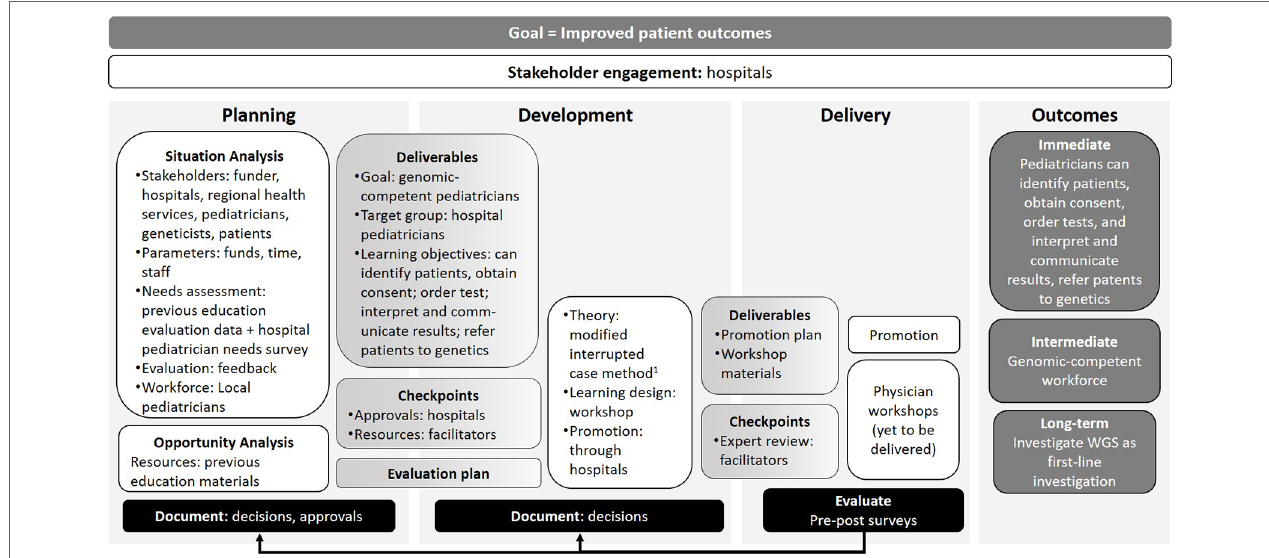
FIGURE 3 | Illustration of how the different program logic model components map to the development of clinical genomic workshops for pediatricians. 1 (Herreid, 2005).